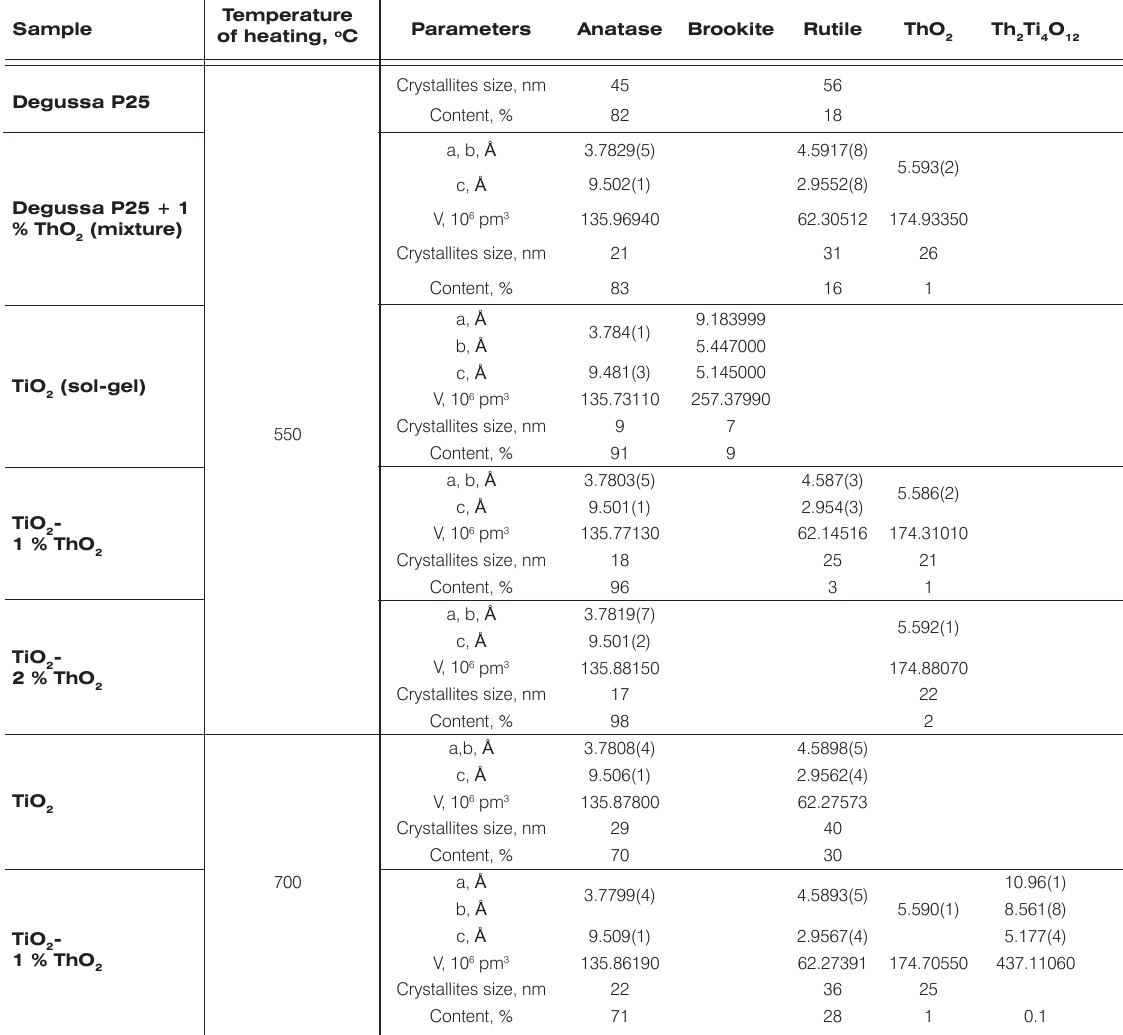
Table 1. Lattice parameters, size of crystallites and phase composition of the studied